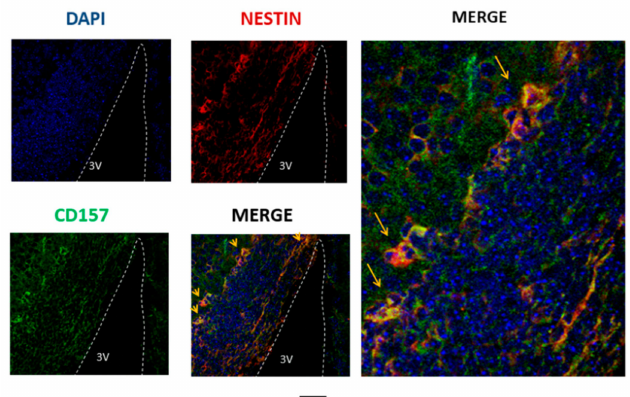
Figure 1. Cluster of di ff erentiation 157 (CD157) expression analyzed by immunofluorescence staining in the embryonic mouse brain. Representative images were obtained from the E17 embryonic hypothalamus near the third ventricle (3V). CD157 is stained in green, nestin in red, and the nucleus in blue. Two merged images show the expression of CD157 in neural stem cells. Scale bar, 100 and 30 µ m for the four left and enlarged images,